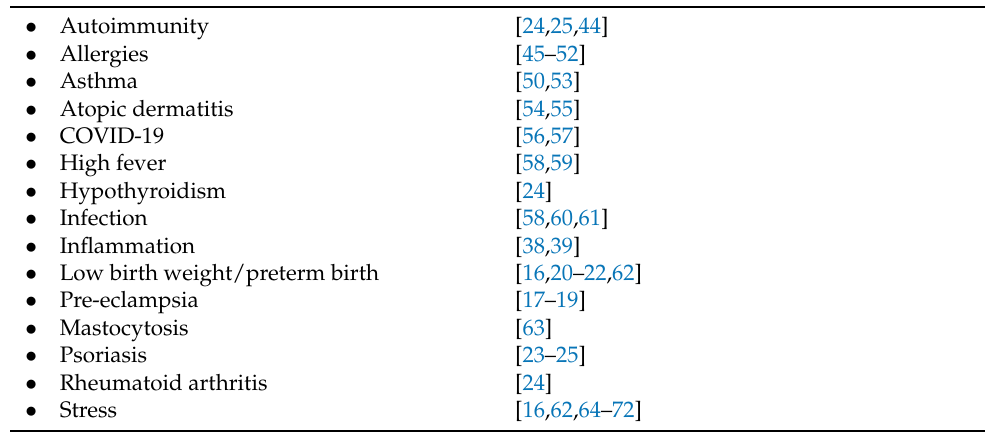
Table 1. Conditions Associated with Higher Risk of